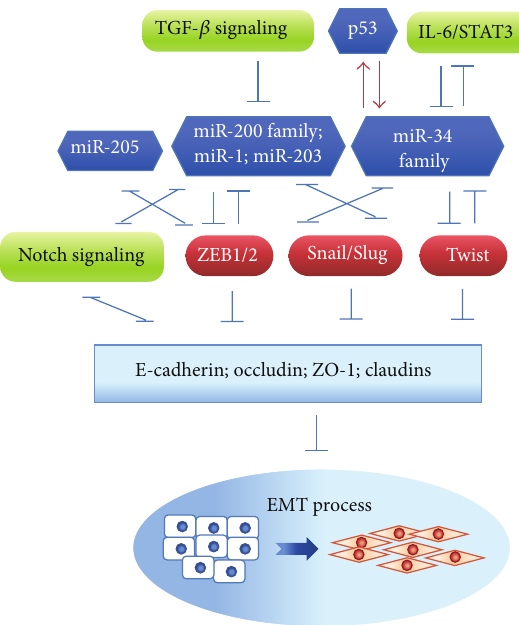
Figure 1: The reciprocally regulatory feedback loop between miRNAs and EMT-TFs that are involved in EMT. miRNAs form regulatory networks with EMT-TFs and EMT-associated signaling pathways that individually or cooperatively modulate EMT. EMT- suppressing miRNAs, such as the miR-200 family, miR-1, miR-203, and the miR-34 family (in blue), reciprocally suppress EMT-TFs (ZEB1/2, Snail/Slug, and Twist) and consequently downregulate the expression of epithelial markers (E-cadherin, occludin, ZO-1, and claudins). This negative feedback loop can be broken by TGF- 𝛽 or IL-6/STAT3 signaling, and